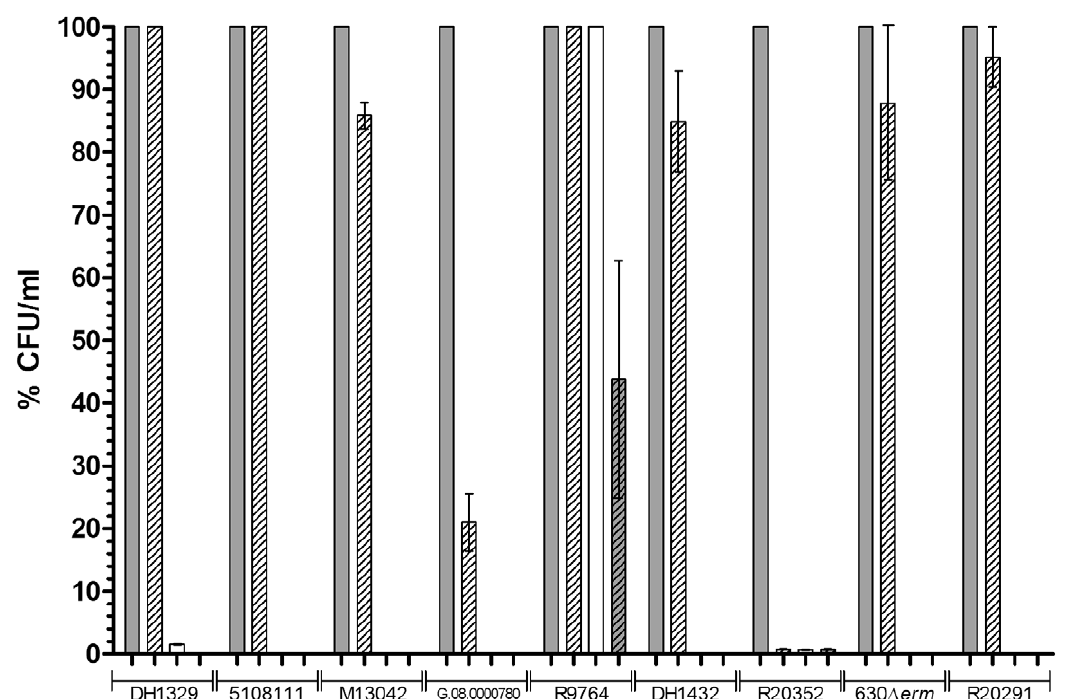
Figure 1. The CFU/ml formed on BHIS agar by nine C.difficile isolates after incubation with germinants. Spores of C. difficile were heat treated at 60 u C for 25 min. CFU/ml were then enumerated on BHIS agar after 2 h incubation of spores with either i) BHIS supplemented with 0.1% (w/ v) taurocholate (filled bars); ii) BHIS supplemented with 0.1% (w/v) taurocholate and 2 mM chenodeoxycholate (empty bars, diagonal lines); iii) BHIS alone (empty bars); or iv) dH 2 O (filled bars, diagonal lines). Colony formation was expressed as the percentage of CFU/ml observed compared to the CFU/ml observed after incubation with the positive control, BHIS supplemented with taurocholate. The data represent the average of three independent experiments and error bars indicate the standard errors of the means.